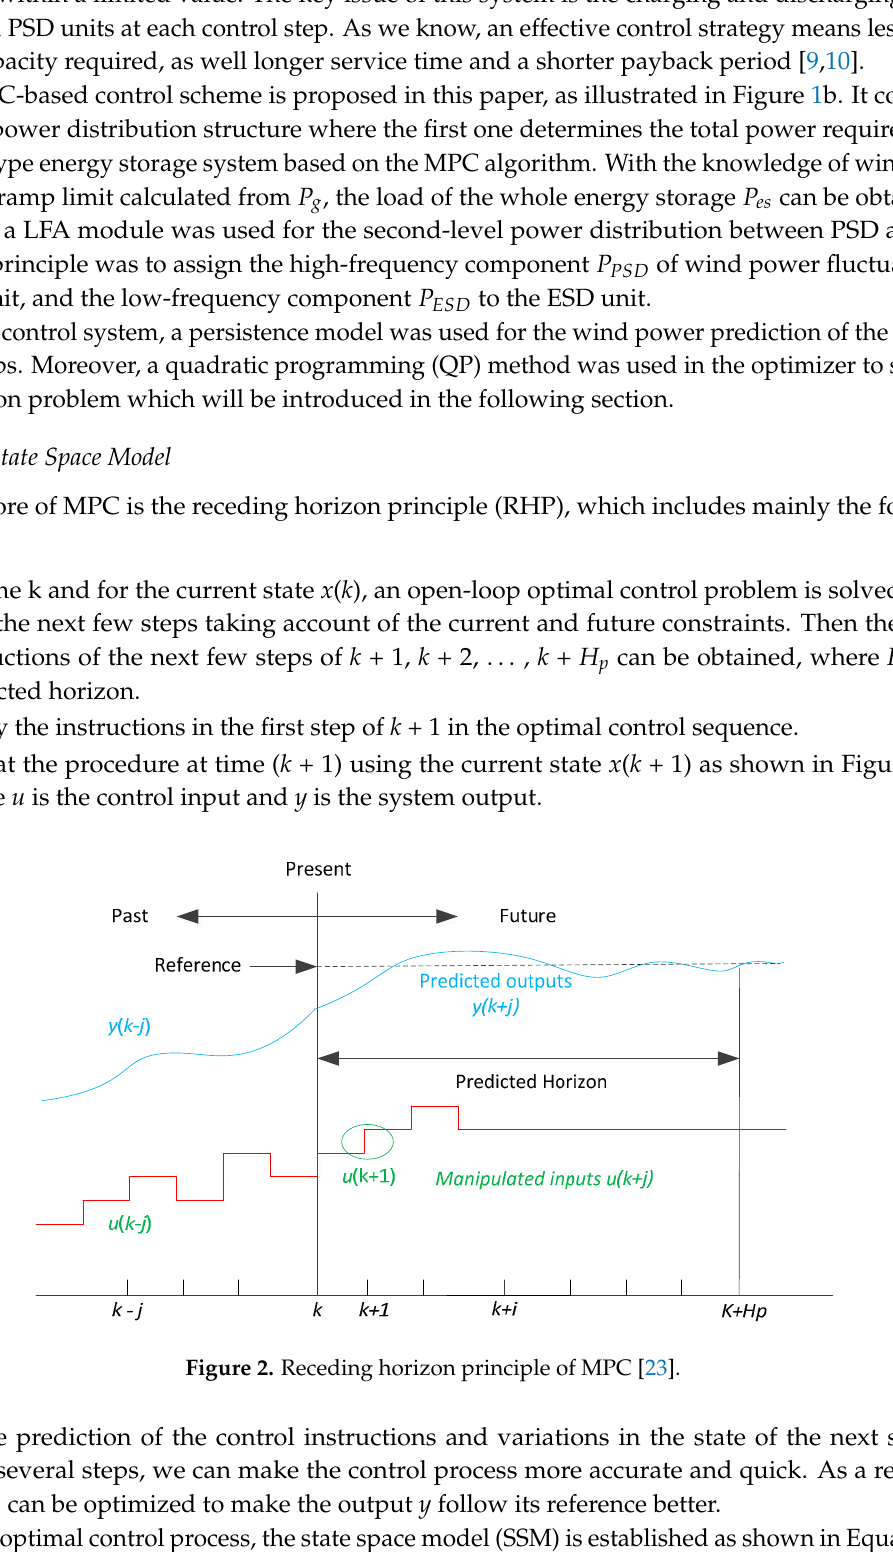
Figure 1. ( a ) Multi-type energy storage for wind power fluctuation smoothing. ( b ) Coordinated control based on MPC. ( H p is MPC predicted horizon).